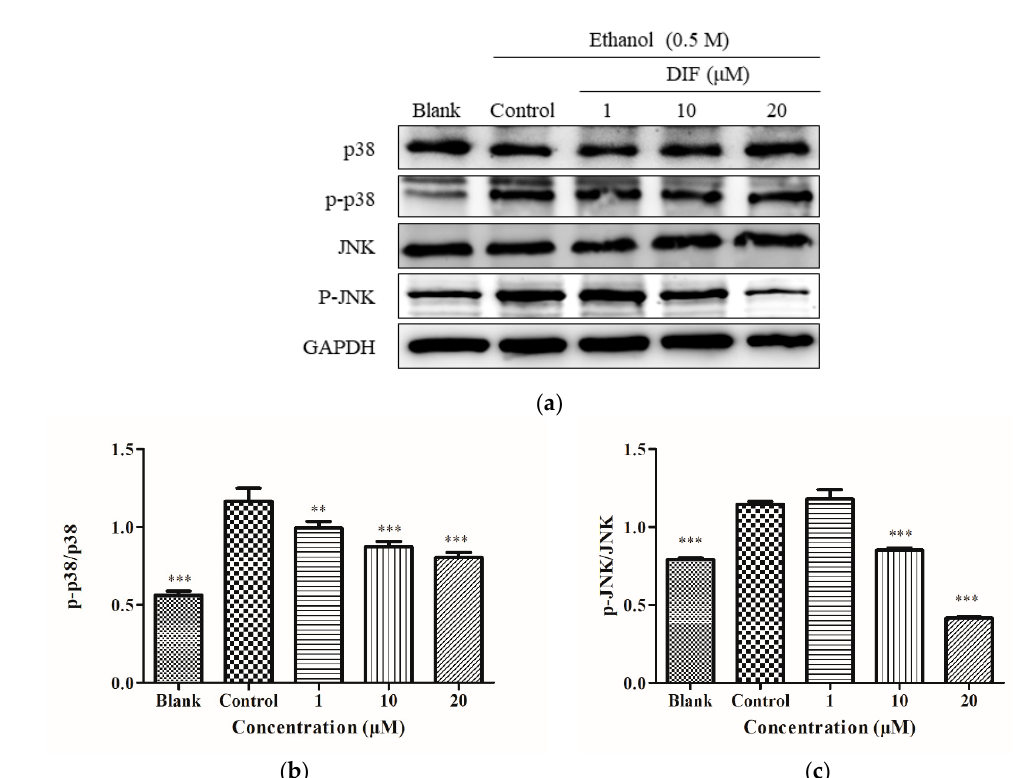
Figure 6. ( a ) The phosphorylation levels of p38, p-p38, JNK, and p-JNK proteins in HepG2 cells. Cells were treated with DIF (1, 10, and 20 μ M) for 2 h, and then treated with 0.5 M ethanol for 24 h. ( b ) The ratios of p-p38 / p38 were calculated. ( c ) The ratios of p-JNK / JNK were calculated. Data are shown as mean ± SD (n = 3). ** Compared with the control group, p < 0.01. *** Compared with the control group, p < 0.001.